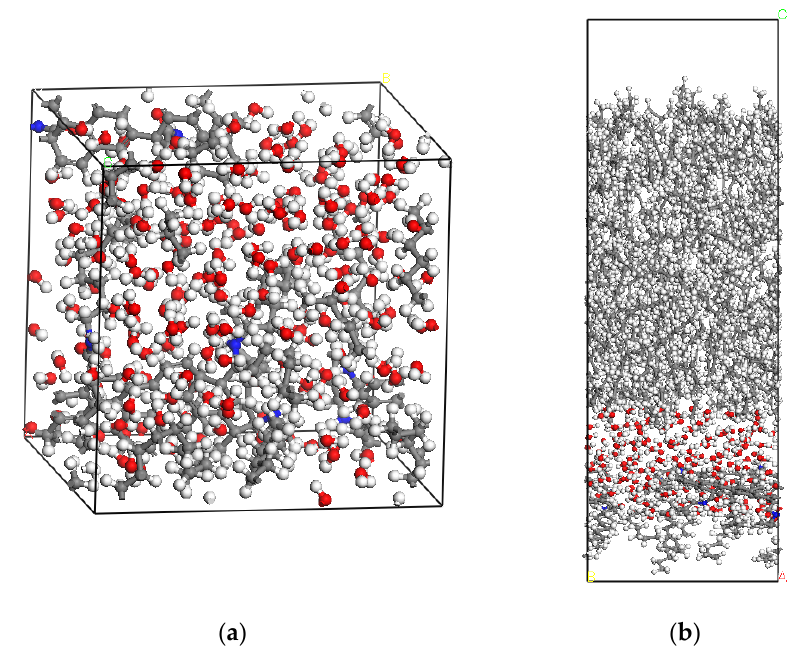
Table 4. Model II force field parameters.